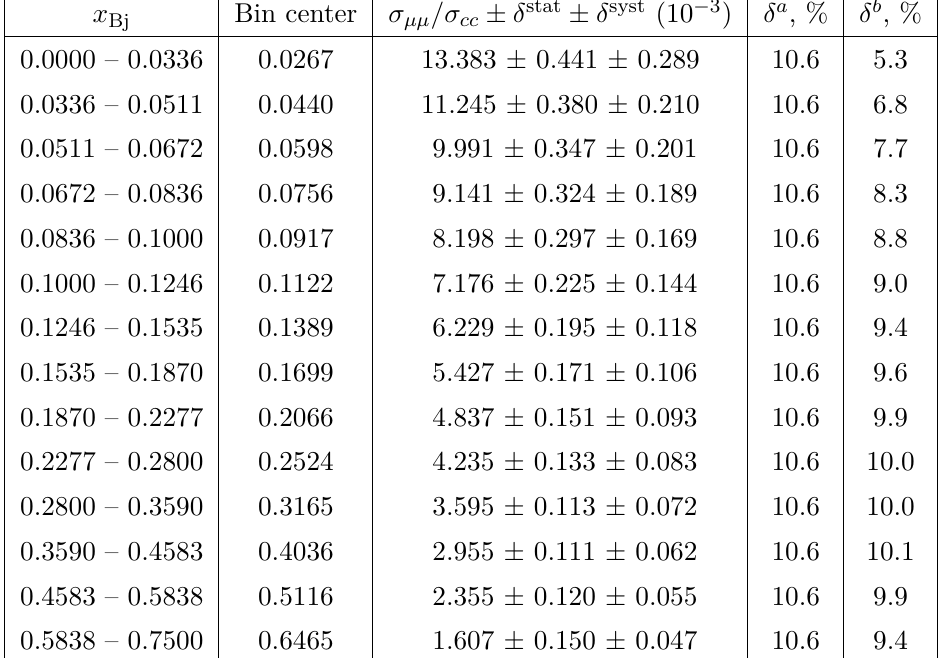
Table 6 . NOMAD measurements on the Bjorken- x distribution of dimuon to inclusive CC cross section ratio, including the binning, central values, statistical and total systematic uncertainties. The last two columns show the additional correlated systematic uncertainties in percentages, if converting back to production cross sections of charm-quark, due to input parameter a and b respectively. These additional errors are derived based on theoretical cross sections at NLO with CT18 NNLO